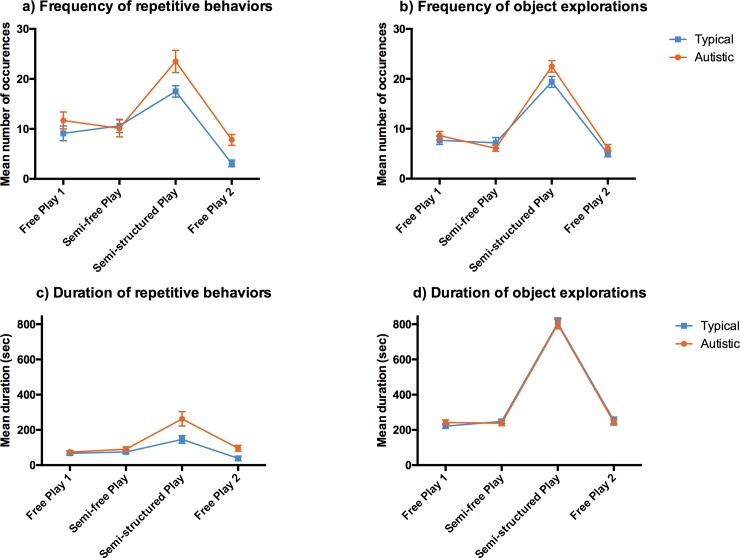
Frequency (number of occurrences) and duration (in seconds) of repetitive behaviors and object explorations in autistic and typical children across play periods, full sample.Error bars are standard error of the mean.